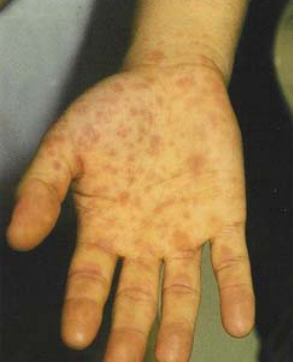
Figure 3. Spots in the palm of the hand of a Rocky Mountain spotted fever patient